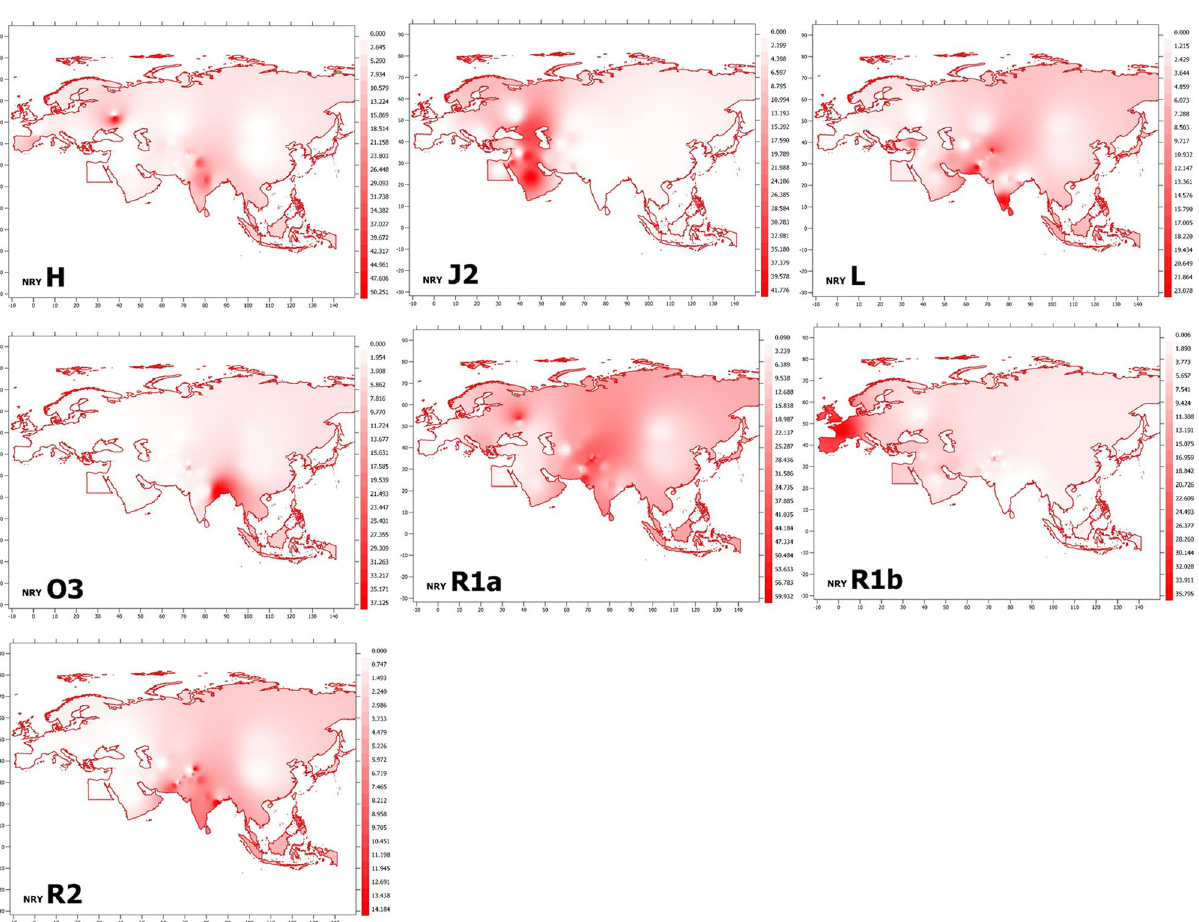
Figure 3. A geospatial map of NRY haplogroup frequencies in KPP ethnic groups and comparative populations. See the Methods section for a description of the mapping process, and Table S6 for the data on which the projection is